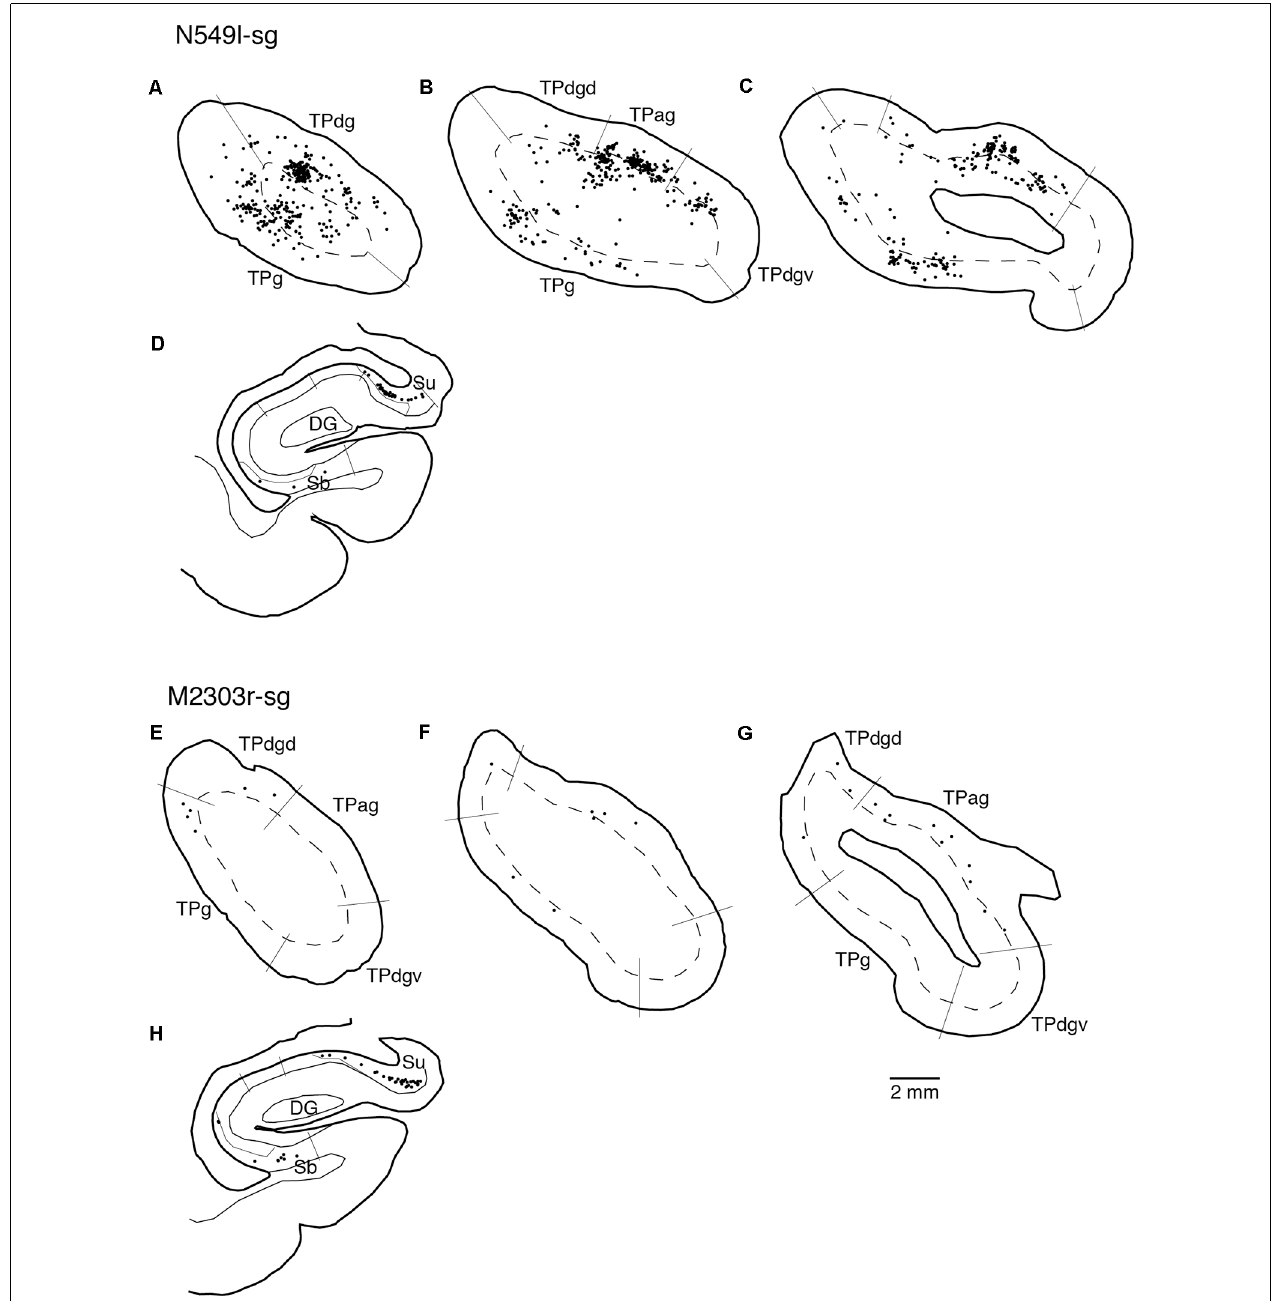
FIGURE 5 | Distribution of the labeled neurons in the TP and hippocampal formation after injections into the sgACC in two cases (N549l-sg and M2303r-sg). The sections through the TP are arranged from anterior to posterior (A–C and E–G) . (D,H) Sections through the hippocampus. Broken lines indicate the internal granular layer or border between layer III and layer V. DG, dentate gyrus; S (b, u), subiculum (body and uncal portion); TP (ag, dgd, dgv, g), temporal pole cortex (agranular, dorsal dysgranular, ventral dysgranular, and guranular subdivision).